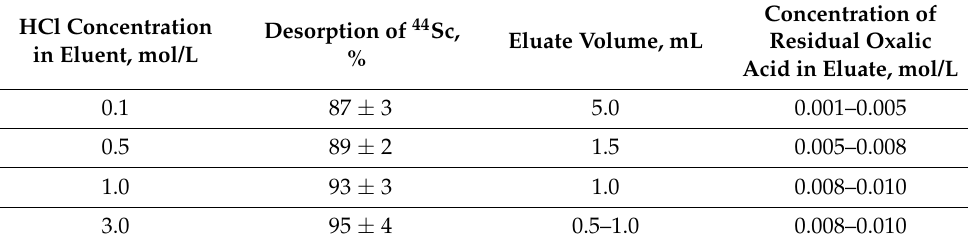
Table 5. Desorption of 44 Sc from Presep ® PolyChelate resin with HCl of different concentration (mean ± SD, %; n =